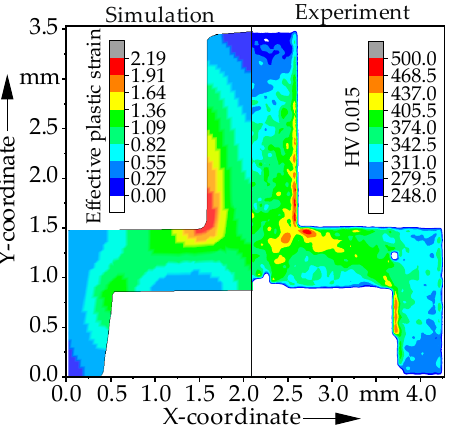
Figure 6. Comparison of the effective plastic strain with the microhardness measurement of a pin with a height of 2 mm and a diameter of 1.0 mm.